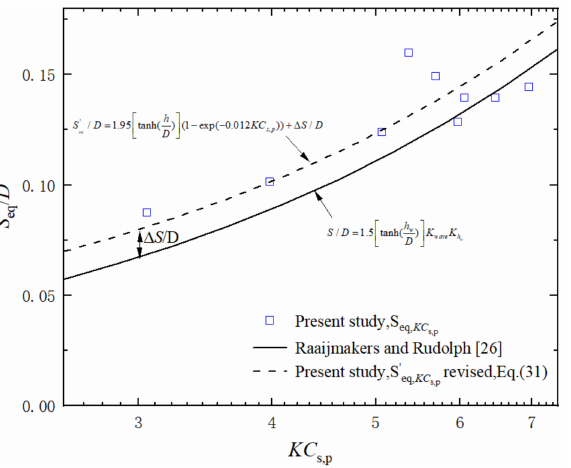
Figure 16. Comparison of S eq between the simulating results and the predicting values by Equation (31).